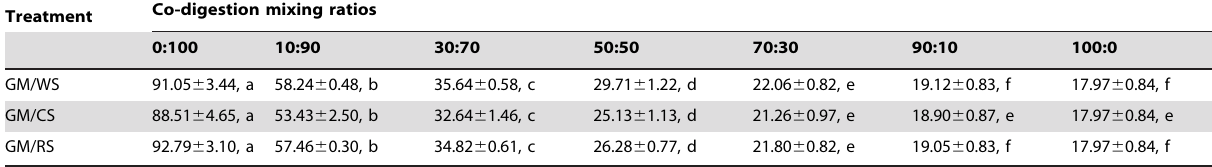
Table 2. Mean values for C/N ratios in the co-digestion of GM with three CRs.